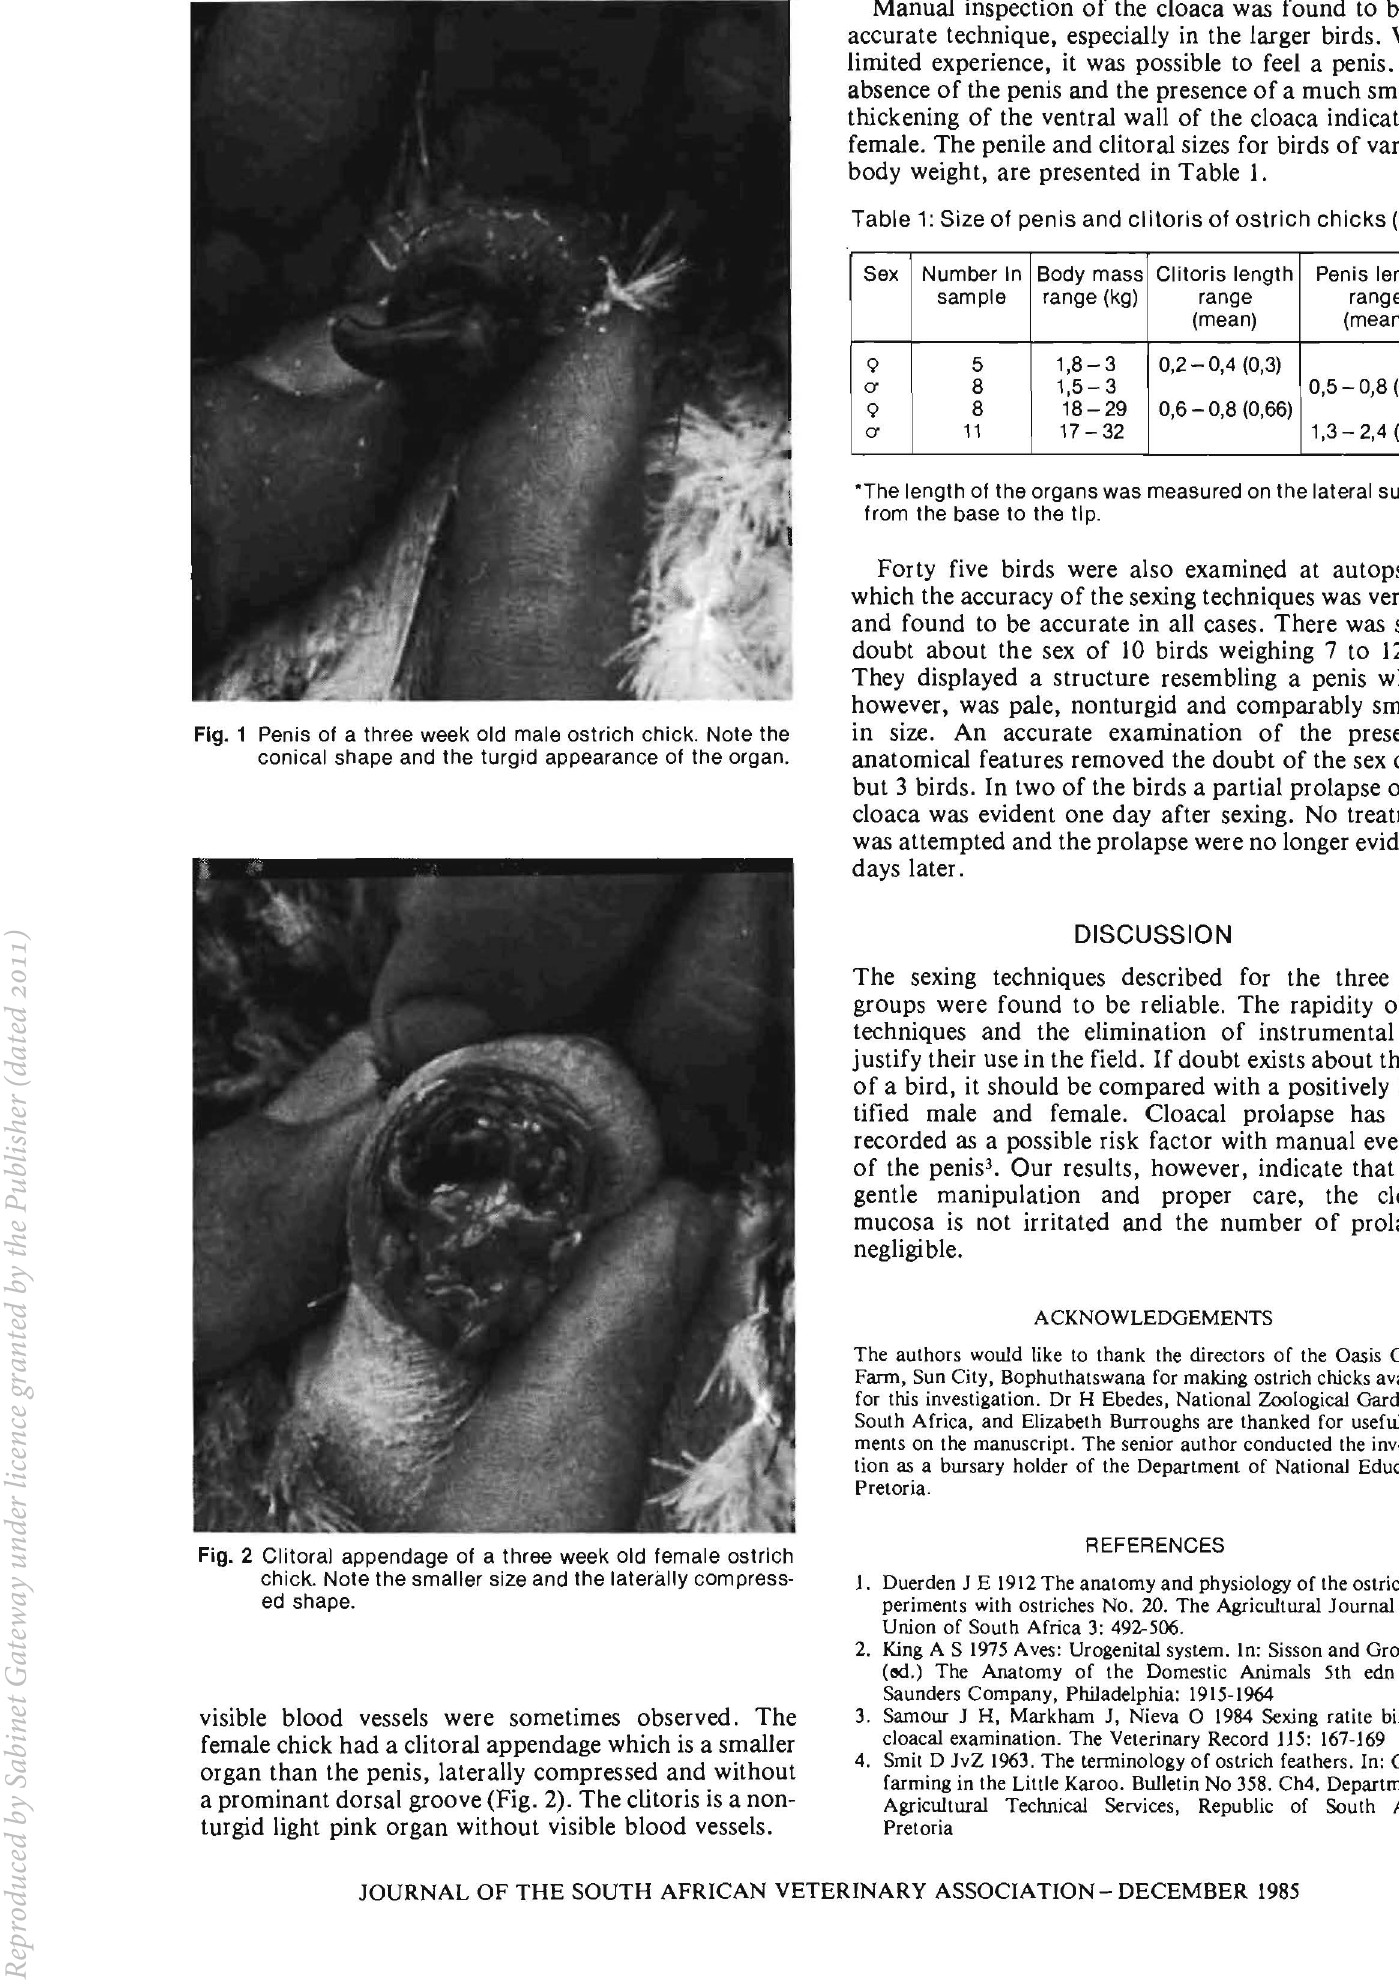
Fig. 2 Clitoral appendage of a three week old female ostrich chick. Note the smaller size and the laterally compress ed shape.